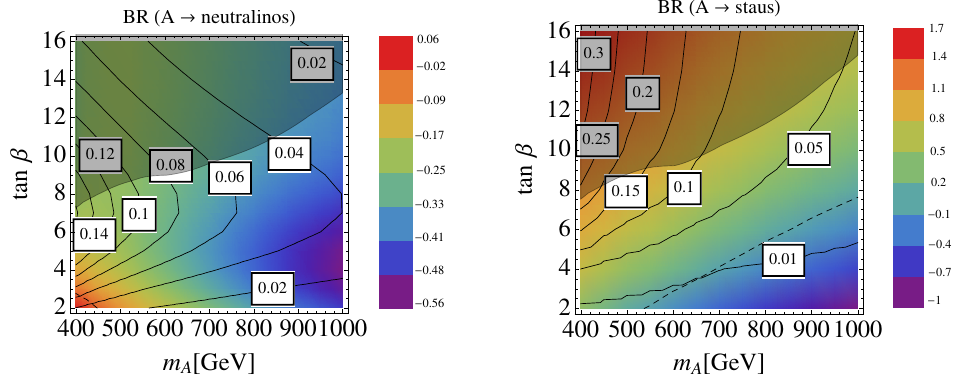
Figure 3 . Left panel: curves with numerical labels denote contours of Br( A ! neutralinos). For this scan, we set M 1 = 150 GeV, (cid:22) = m A (cid:0) 175 GeV, M 2 = 2 TeV, all soft terms A f = (cid:22) = tan (cid:12) + 1600 GeV, and all other dimensionful parameters to 1 : 5 TeV. These parameters are similar to the m mod+ scenarios from [59], except for the modi(cid:12)ed values of M 1 ; M 2 ; and (cid:22) . The color h coding represents the ratio of electroweakino production cross section via heavy Higgs decay to direct Drell-Yan production cross section, log 10 ( (cid:27) ( pp ! A; H ! neutralinos)/ (cid:27) ( pp ! electroweakinos)), where the numerator includes contributions from both gluon fusion and b-associated production of A and H , and the denominator includes all direct neutralino and chargino production modes. The dashed line indicates the contour along which these two production cross sections are equal. Right panel: analogous plot for Br( A ! staus), with parameter choices the same as for the neutralino plot, except m ~ (cid:28) = m ~ (cid:28) = m A = 2 (cid:0) 50 GeV, A (cid:28) = 1 TeV, and (cid:22) = 500 GeV, which are similar to L R the light stau scenario in [59] except for the modi(cid:12)ed values of A (cid:28) ; m ~ (cid:28) ; m ~ (cid:28) ; and M 2 . In both L R panels, the shaded regions represent the parameter space excluded by currents LHC searches for A=H ! (cid:28)(cid:28) [1, 2], whereas all non-shaded regions are consistent with all current LHC bounds from various